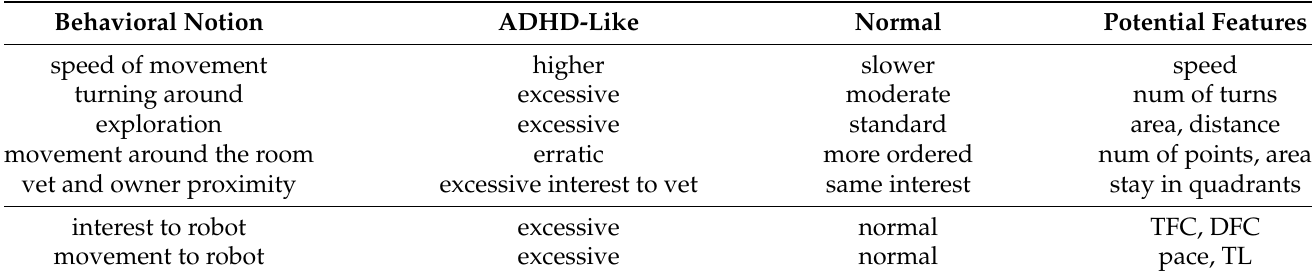
Table A2. Experts’ descriptions and mapping to